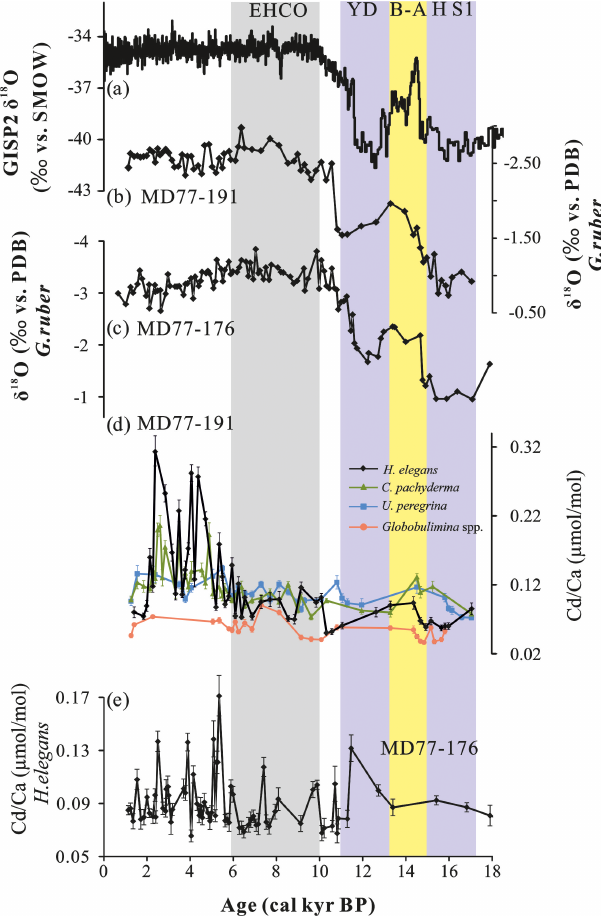
Figure 2. (a) GISP2 Greenland ice core δ 18 O signal (Stuiver and Grootes, 2000). (b, c) Globigerinoides ruber δ 18 O records of cores MD77-191and MD77-176, respectively (Marzin et al., 2013; Ma et al., 2020). (d) Cd / Ca records of the benthic foraminifera Hoeglun- dina elegans (black), Cibicidoides pachyderma (green), Uvigerina peregrina (blue) and Globobulimina spp. (orange) obtained from core MD77-191. (e) Cd / Ca records of the benthic foraminifera H. elegans from core MD77-176. EHCO stands for Early Holocene Climate Optimum, YD for Younger Dryas, B-A for Bølling–Allerød and HS1 for Heinrich stadial